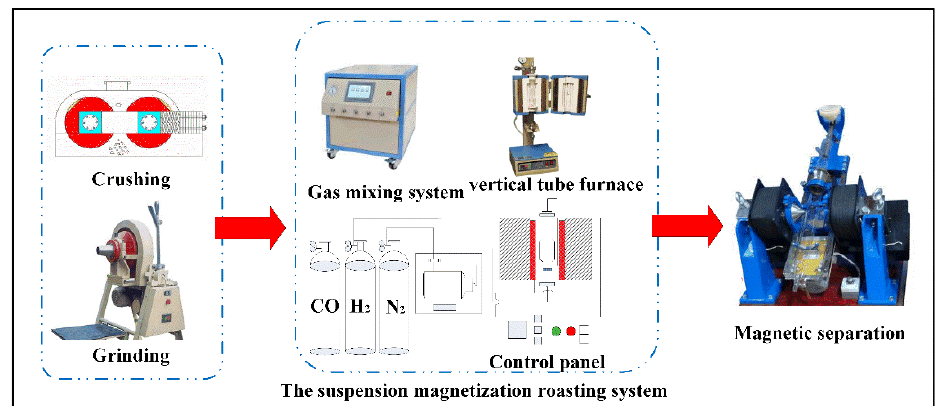
Figure 3. Flow chart of the experiment process.